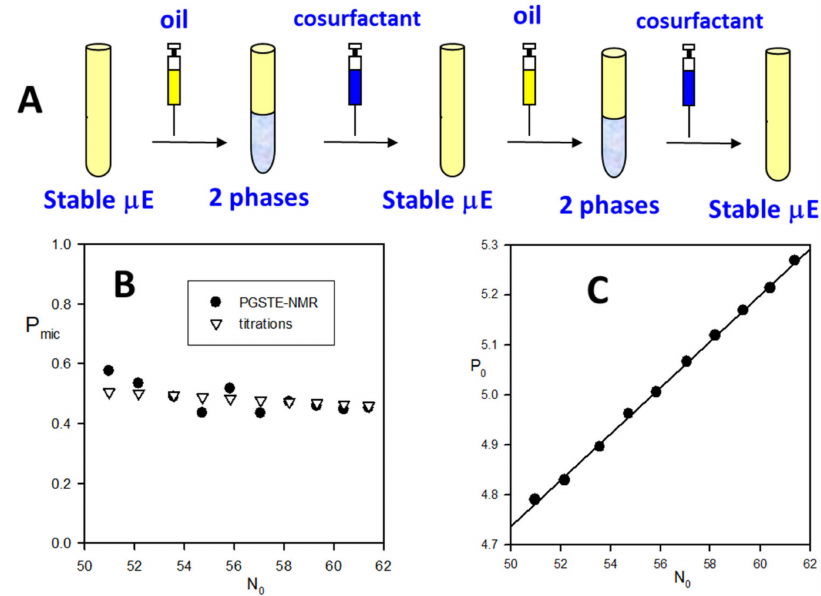
Figure 5. ( A ) Steps of Schulman’s titration: subsequent additions of oil and cosurfactant, respectively, destabilize and stabilize the w / o µ E. ( B ) The P mic (fraction of cosurfactant in micelle) vs. N 0 (oil / surfactant mole ratio) plot shows how the cosurfactant concentration remains constant during the titration; closed dots are from dNMR experiments while open triangles are from the titration of ( C ). ( C ) Representative Schulman’s titration: P o (alcohol / surfactant molar ratio) vs. N 0 plot. The straight line is the best fit to Equation (11). The intercept is the minimum cosurfactant / surfactant ratio for the uE and the slope represents the bulk composition; the open triangles of ( B ) are P mic = intercept / P o . Adapted with permission from [49]. Copyright (2004) American Chemical